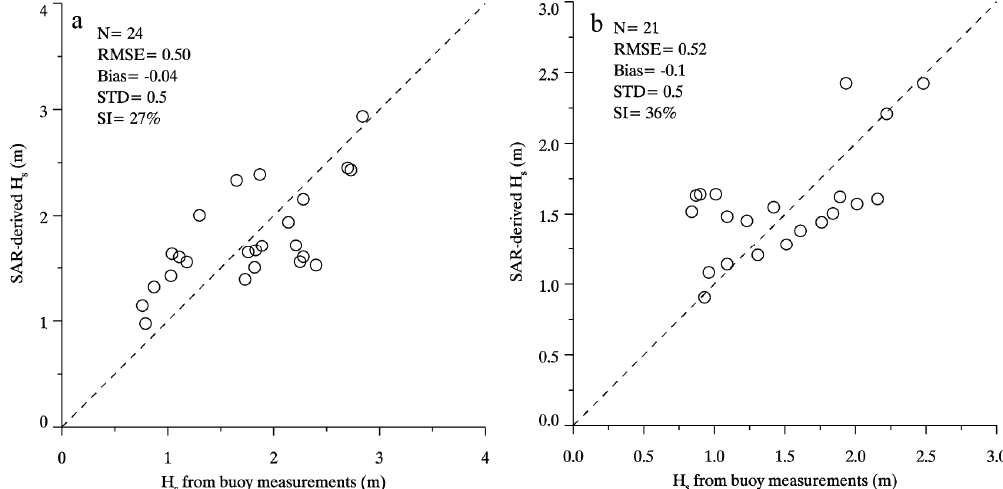
Figure 8. SWH retrieval results from TS-X/TD-X images are compared with buoy measurements: ( a ) VV-polarization images; and ( b ) HH-polarization images.